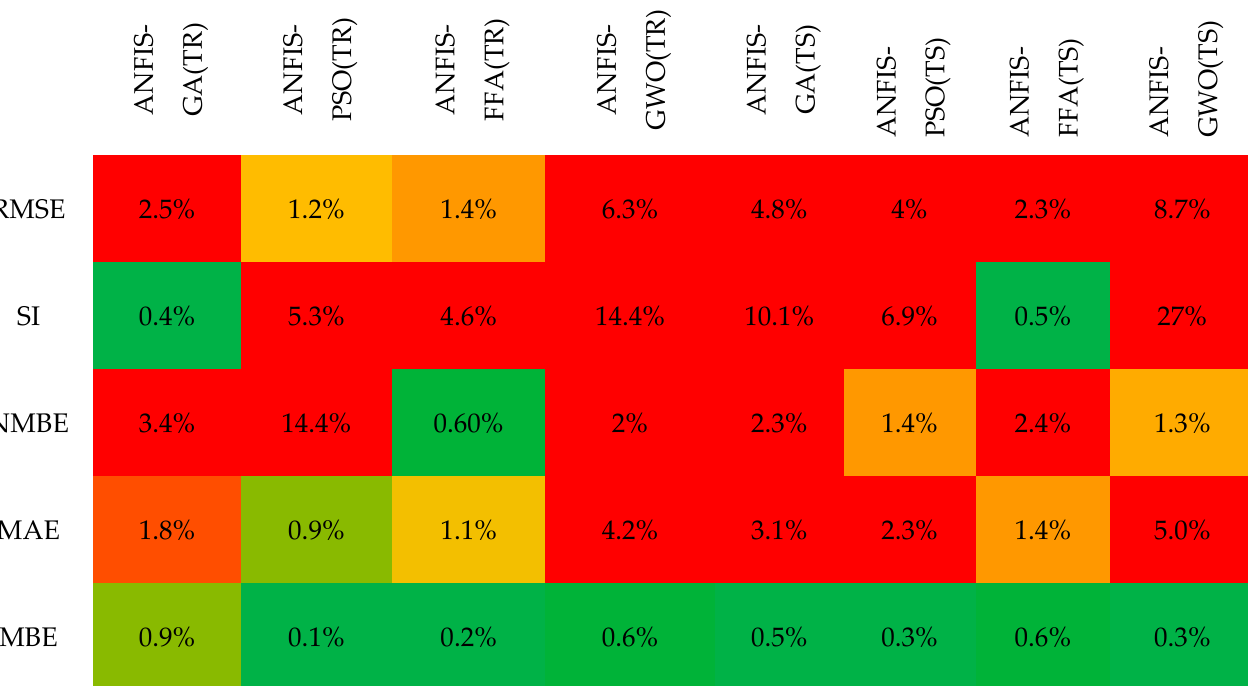
Figure 10. Error matrix for error measuring parameters (training and testing dataset).